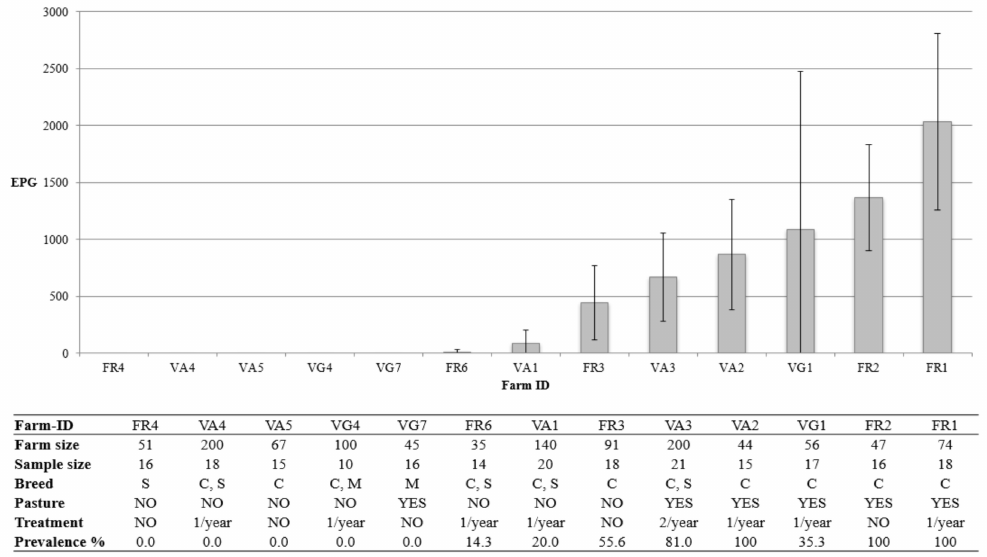
Figure 3. Mean abundance and 95% confidence interval of GIS in relation to the main characteristics of individual farms (n = 214). EPG = eggs per gram of faeces; C = Camosciata; M = Murciana; S =